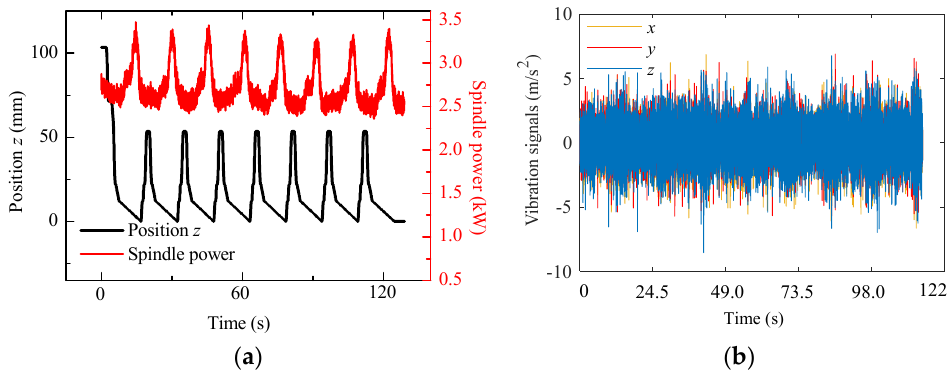
Figure 2. Raw signals with cutting parameters cutting speed v c = 60 m/min, feed speed F = 318 mm/min: ( a ) Spindle power; ( b ) Vibration.